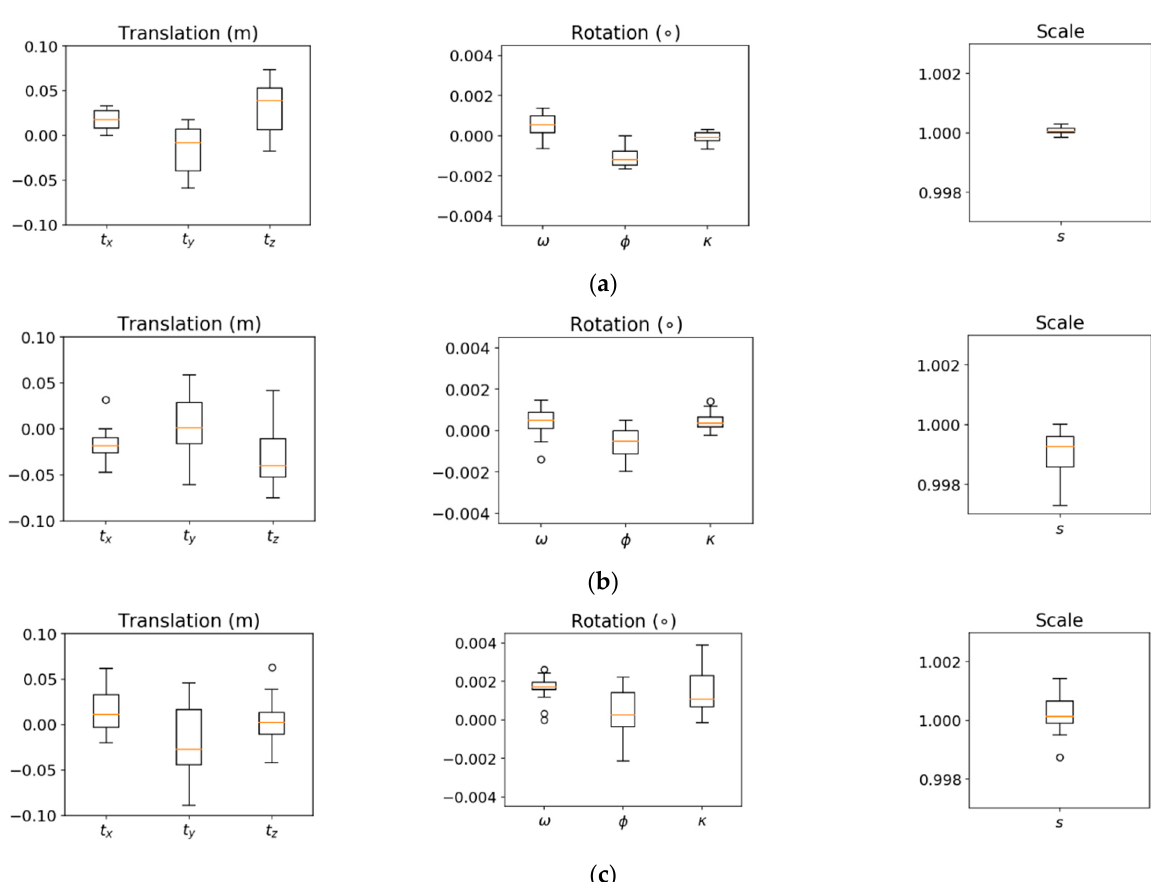
Figure 14. Extracted planar/linear/cylindrical features (in blue/red/green, respectively) for the reg- istration of ( a ) TLS, ( b ) PWMMS-HA, and ( c ) PWMMS-UHA point clouds.